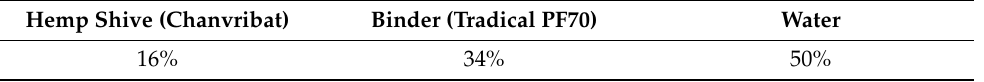
Table 1. Standard proportion of lime binder, hemp shives and water, by mass, for concrete. Hemp Shive (Chanvribat) Binder (Tradical PF70) Water 16% 34% 50%